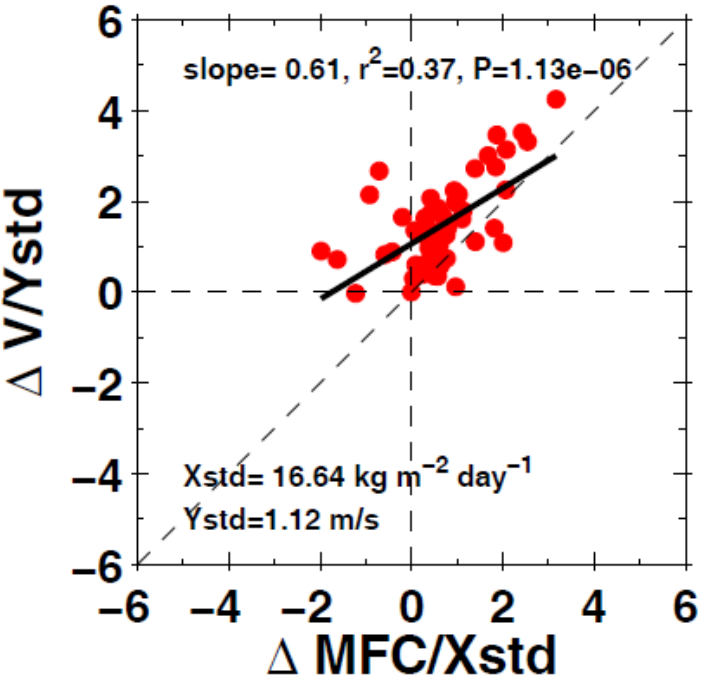
Figure 5. Regression of Δ V vs. Δ MFC , averaged from days 3 to 7, plotted as normalised quantities by their respective standard deviations Ystd and Xstd shown in the bottom legends. Top legends display the regression slope, r 2 and p values. Members (red dots) in the upper-quartile of intensity were used. Black line is the linear least square fit, and the 45 ◦ dashed line is the perfect fit line for